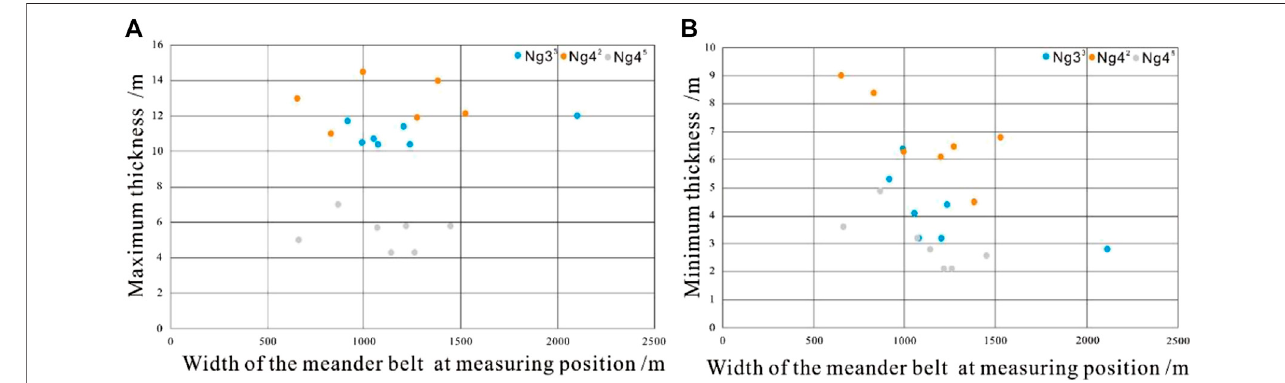
FIGURE5| Width and thickness parametersofmeander-river beltin differentsub-layers. (A) Scatterplot shows thatthere isnocorrelationbetweenthe maximum thickness and width of the meander belt, and the maximum thickness of the meander zone is relatively stable. (B) Scatter plot shows that the minimum thickness of the meander belt decreases as the width of the meander belt increases.